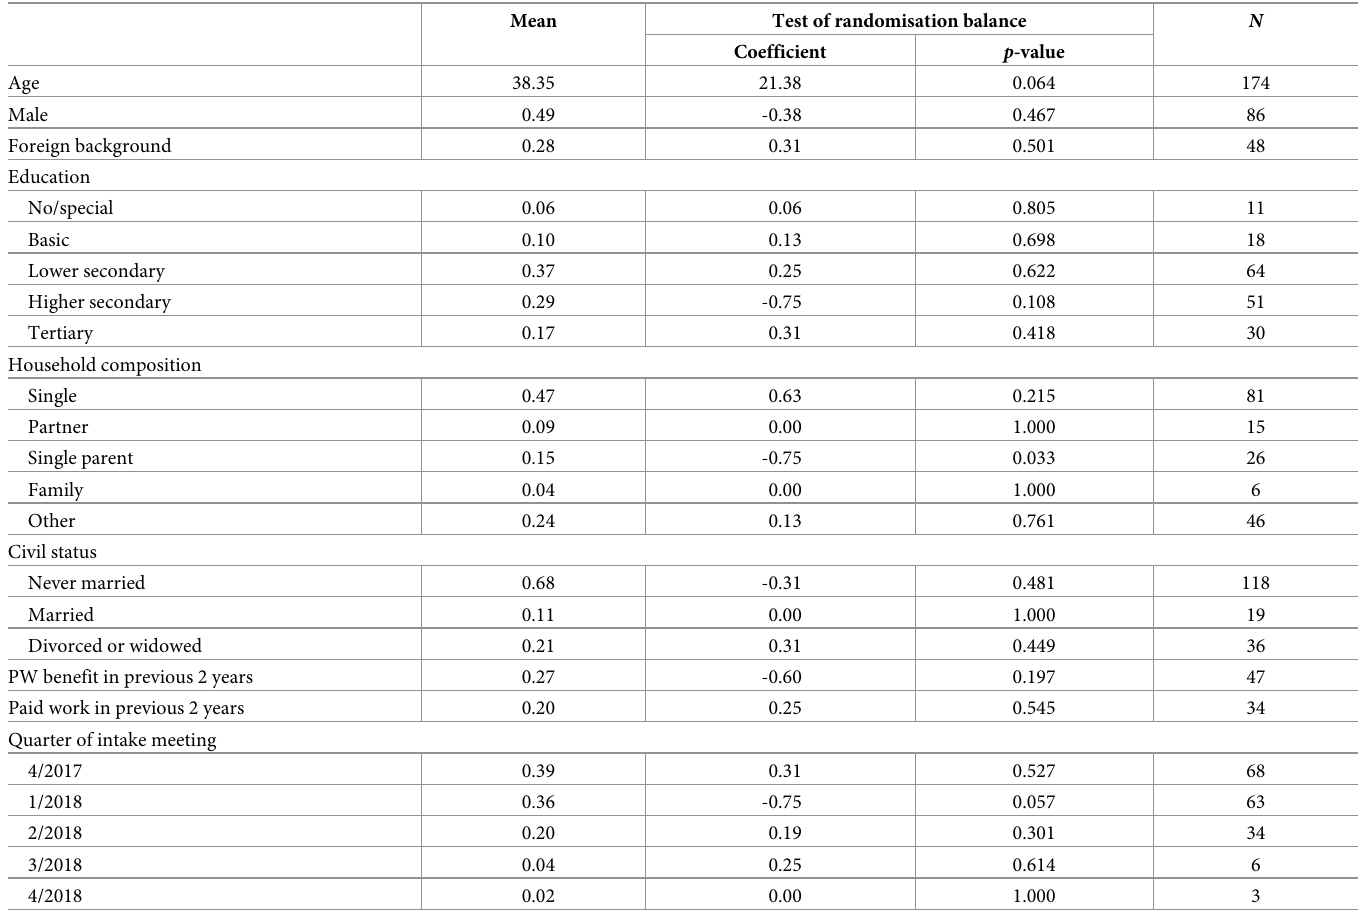
Table 1. Baseline summary statistics and test of balance for